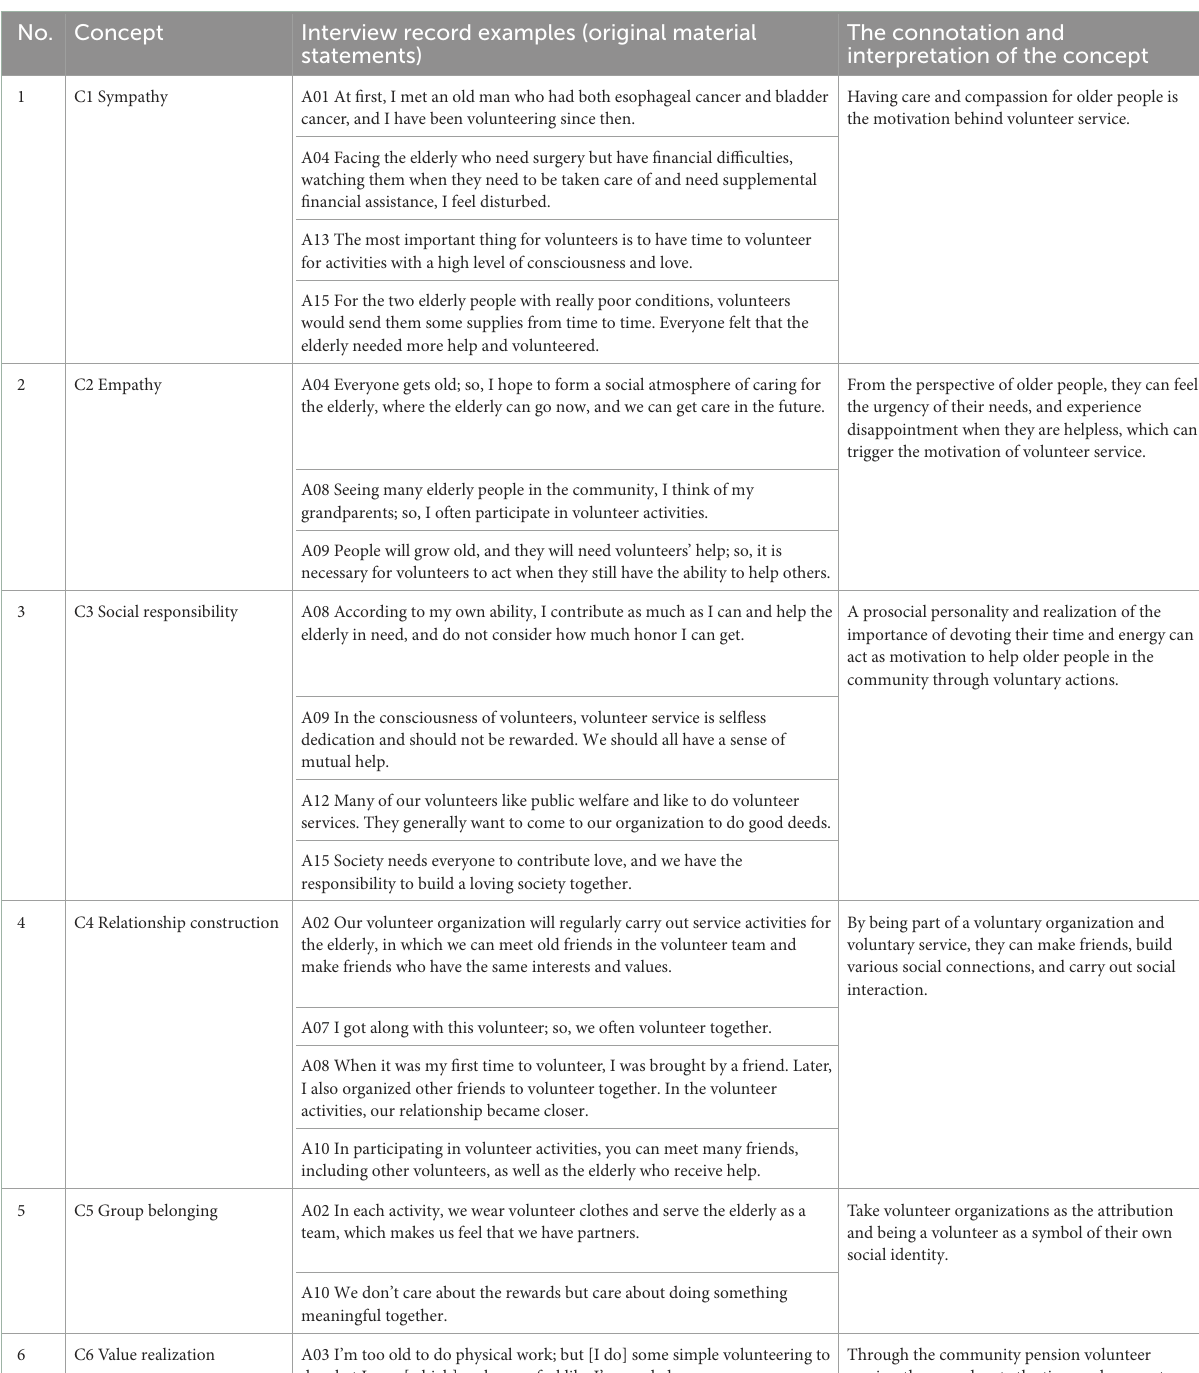
TABLE 1 List of open coding